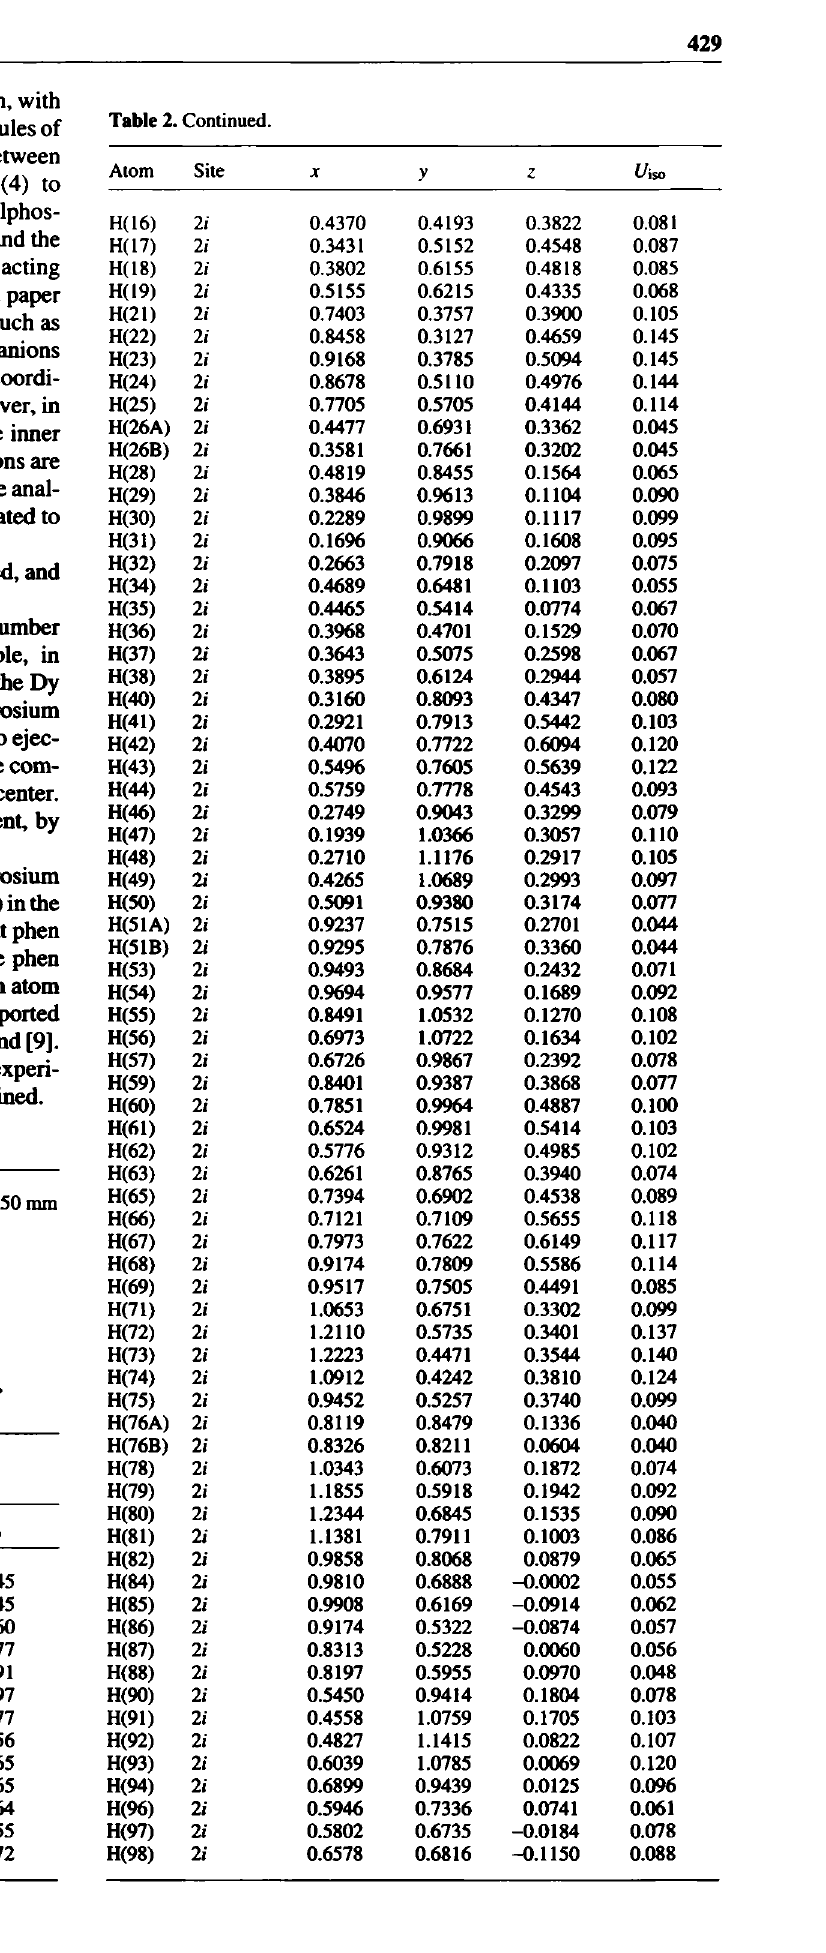
Table 2. Atomic coordinates and displacement parameters (in Â 2